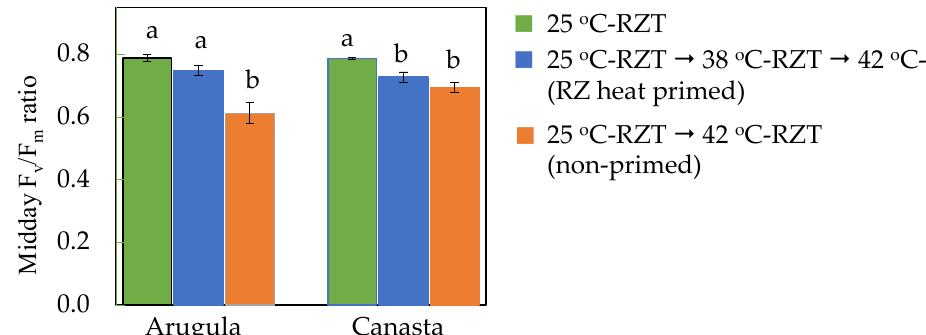
Figure 2. Midday F v /F m ratios measured on 33 DAT. The vertical lines through the means represent standard errors ( n = 4). Different lowercase letters are statistically different ( p < 0.05, Tukey’s multiple comparison test). Each species was analyzed separately. Refer to Section 4.2 for further details on different RZT treatments.